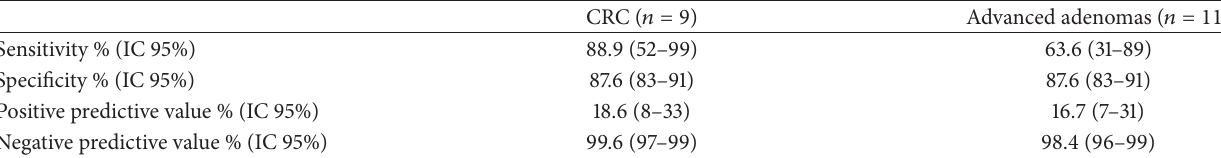
Table 4: FIT performance in detecting CRC and advanced